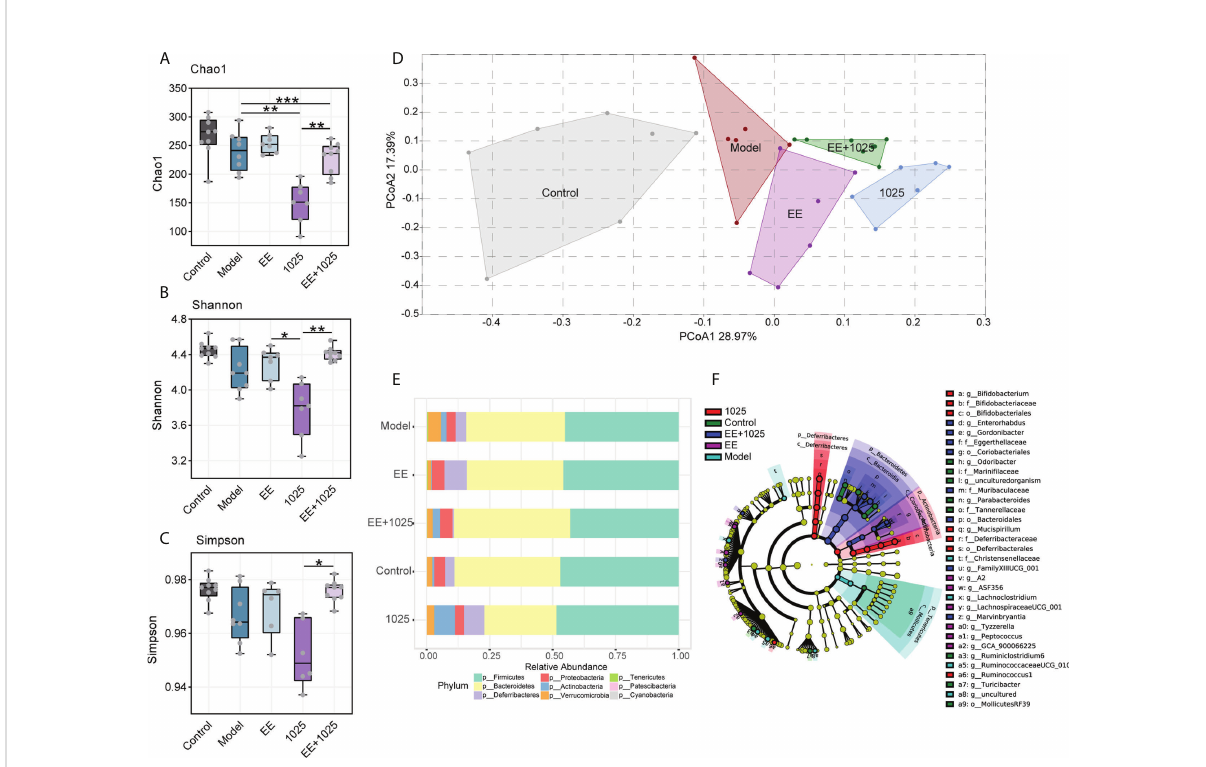
FIGURE 4 Changes in the diversity and structure of gut microbiome in different groups. (A – C) Microbial a -diversity, indicted by Chao 1, Shannon and Simpson indices (n = 6 – 8). In the box plot, the bottom and top are, respectively, the 25th and 75th percentile, a line within the box marks the median. Whiskers above and below the box indicate 1.5 interquartile range of the lower and upper quartile, respectively. Each data point represents one independent mouse. * P < 0.05, ** P < 0.01, *** P < 0.001 as determined by one-way ANOVA. (D) Principal coordinates analysis (PCoA) based on Bray-Curtis distance (PERMANOVA, P = 0.0001; n = 6 – 8). (E) The relative abundance of bacteria at the phylum level (n = 6 – 8). (F) Linear discriminant analysis (LDA) effect size (LEfSe). Differential taxa are labeled with tags and annotated in the right panel. Data were computed with an LDA score above 2.00 and P value below 0.05 for the factorial Kruskal – Wallis